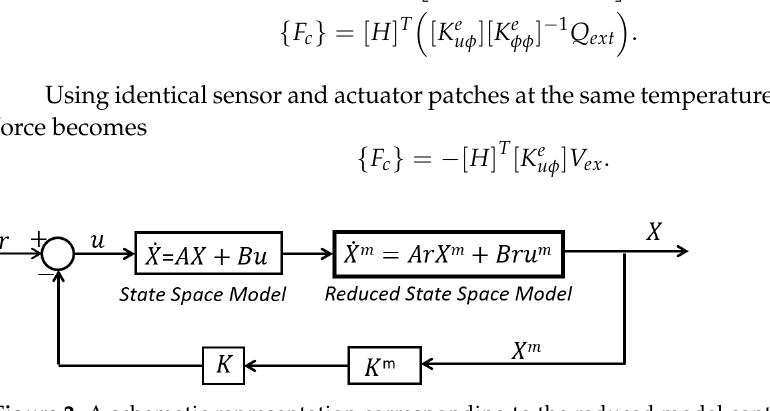
Figure 2. A schematic representation corresponding to the reduced model control